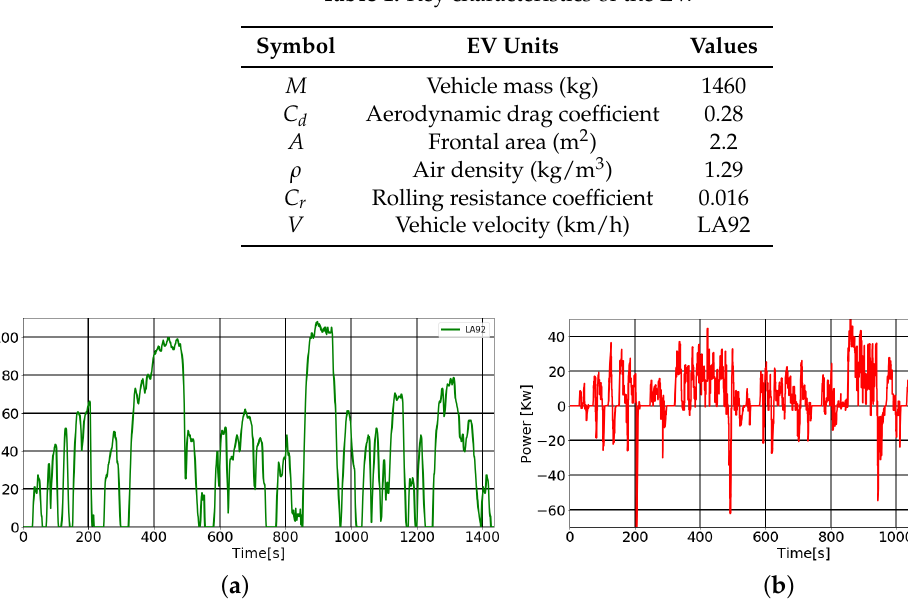
Table 1. Key characteristics of the EV.